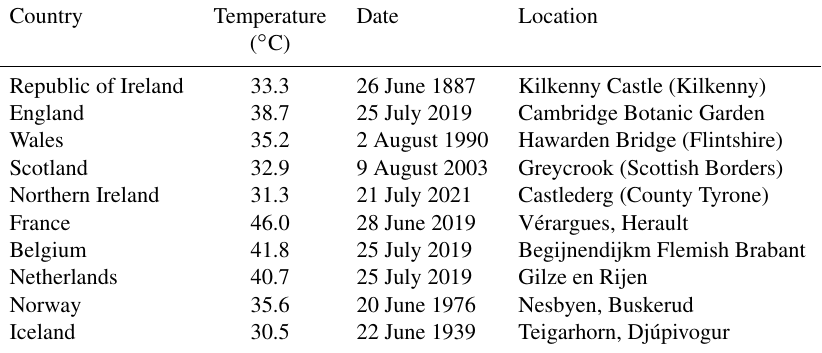
Table 1. Highest daily maximum temperature records of several NW European countries surrounding Ireland including constituent countries of the United Kingdom sourced from various national meteorological service websites at the time of writing.